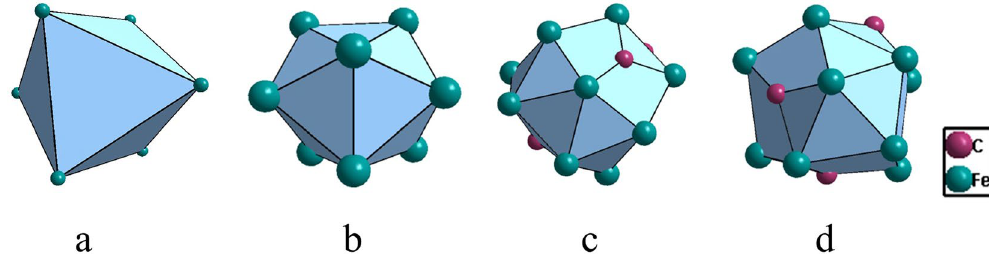
Figure 6. Clusters in C-containing γ -Fe ( a : octahedron) and in CFe 3 ( b ) capped trigonal prism CN9 [C-Fe 9 ]), ( c ) CN15 [Fe-C